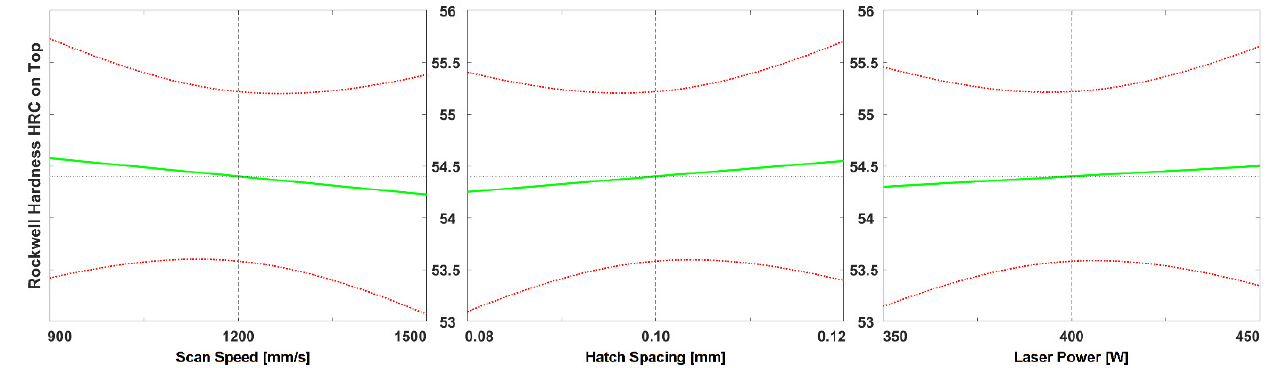
Figure 14. Predicted effects of changes in process parameters on the Rockwell hardness HRC on the top surface, where the green lines are the predictions of hardness on top surfaces and the dotted red lines present the 95% confidence bounds.